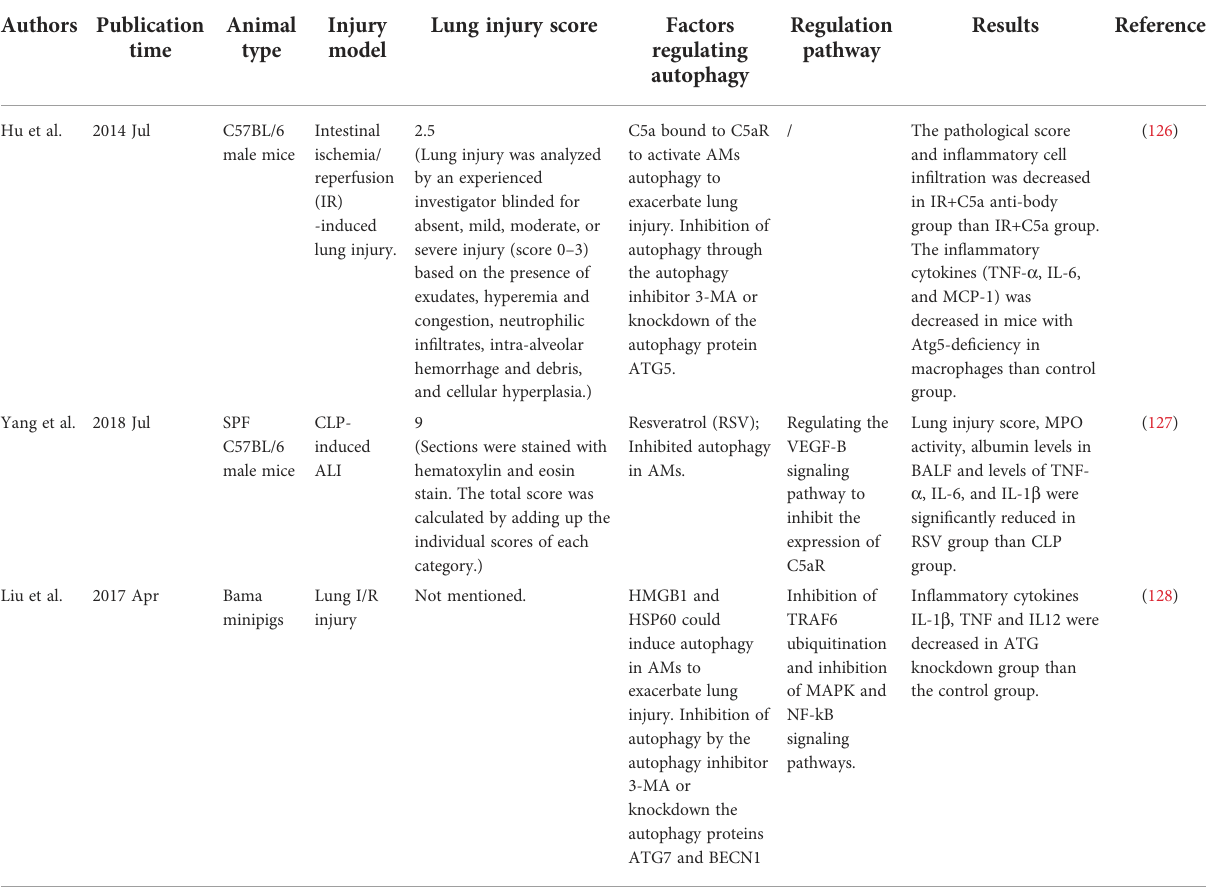
TABLE 2 Macrophage autophagy can aggravate lung injury in animal